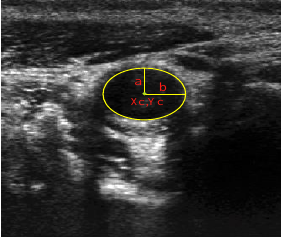
Figure 2. Illustration fitted in the boundaries of an artery.